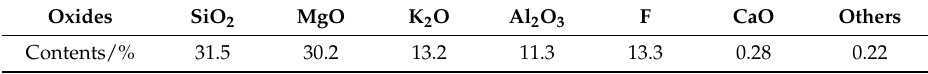
Figure 1. FESEM images of different inorganic fillers: ( a ) APP, ( b ) Al(OH) 3 , ( c ) mica. Table 1. Chemical composition of fluorophlogopite mica.